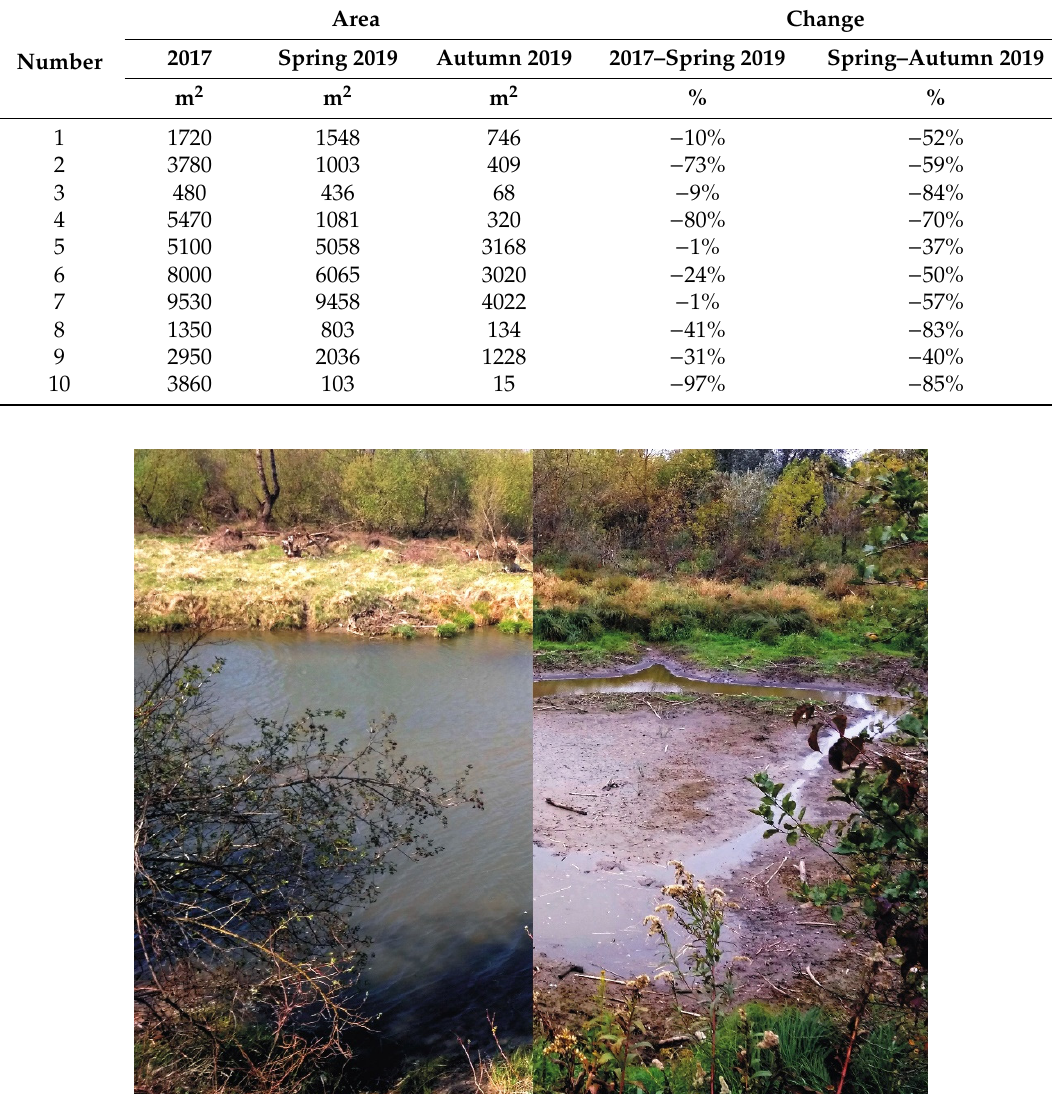
Figure 4. Reservoir number 7 in spring ( left ) and autumn ( right ) 2019.